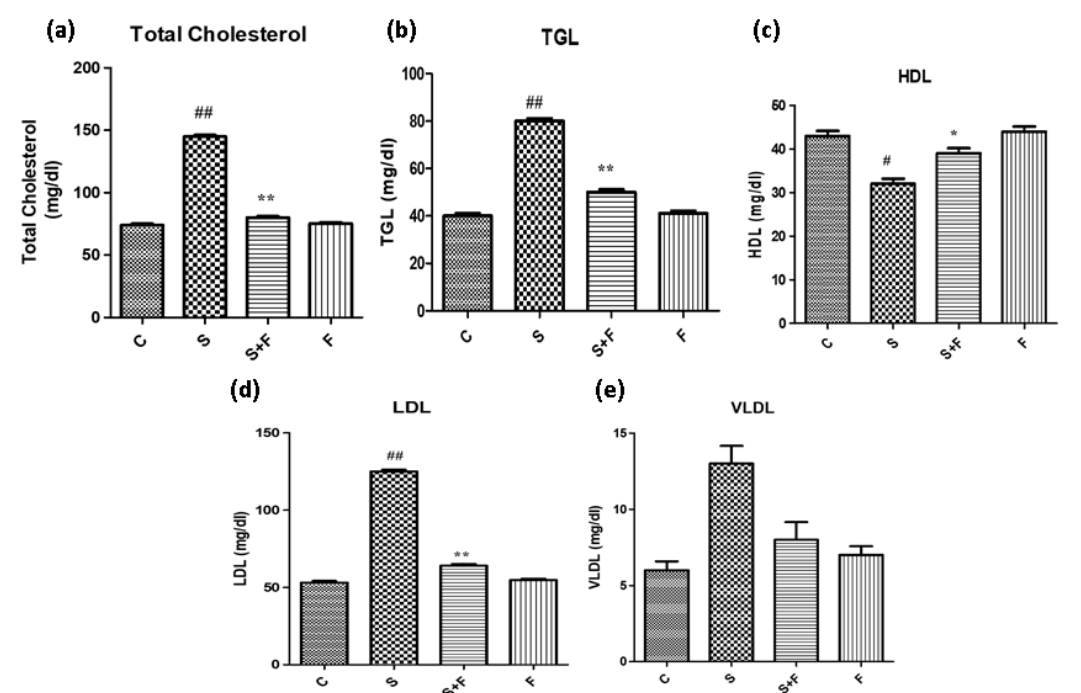
Figure 7. Friedelin reduced blood cholesterol and triglyceride abundance in adult mice. ( a ) TC levels, ( b ) TG levels, ( c ) HDL levels, ( d ) LDL and ( e ) VLDL levels are given in histogram. The results are expressed as mean ± SEM employing one-way ANOVA followed by Tukey’s multiple comparison post-test. Significance of control vs. scopolamine is expressed as #, while * denotes scopolamine vs. scopolamine + friedelin/glutinol. Significance: ns = non-significant * , # p < 0.05, ** , ## p < 0.01 ( n = 5).